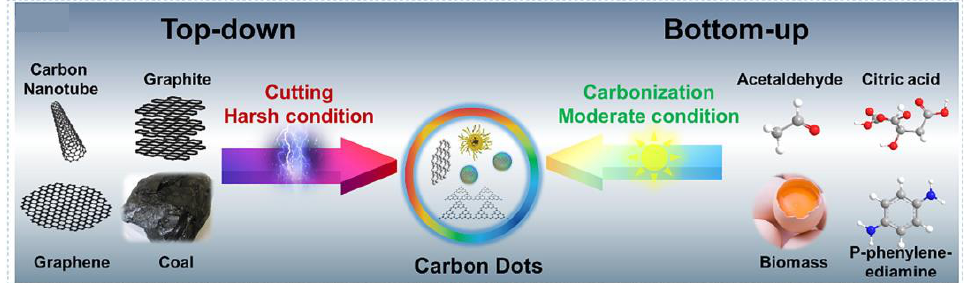
Figure 2. Top-down and bottom-up method approaches to the synthesis of CDs based on their raw materials. Reprinted/adapted with permission from Ref. [54]. Copyright 2021, copyright Elsevier.